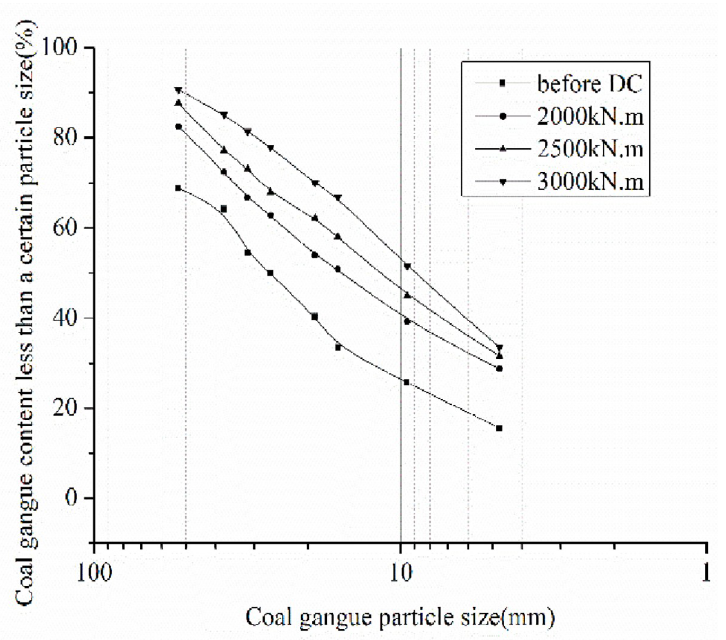
Fig 12. Passage rate curve of coal gangue particles after different tamping